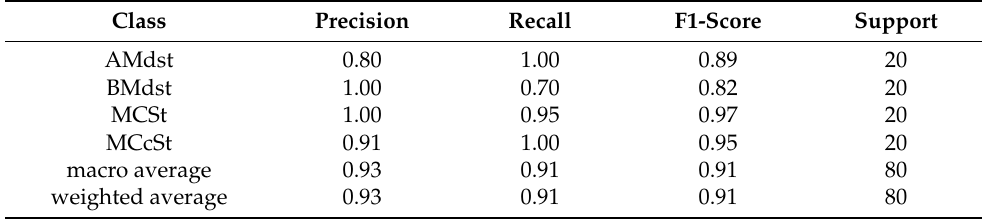
Table A8. Classification report for ResNet18 pretrained on MSI vs. MSS. The overall accuracy is